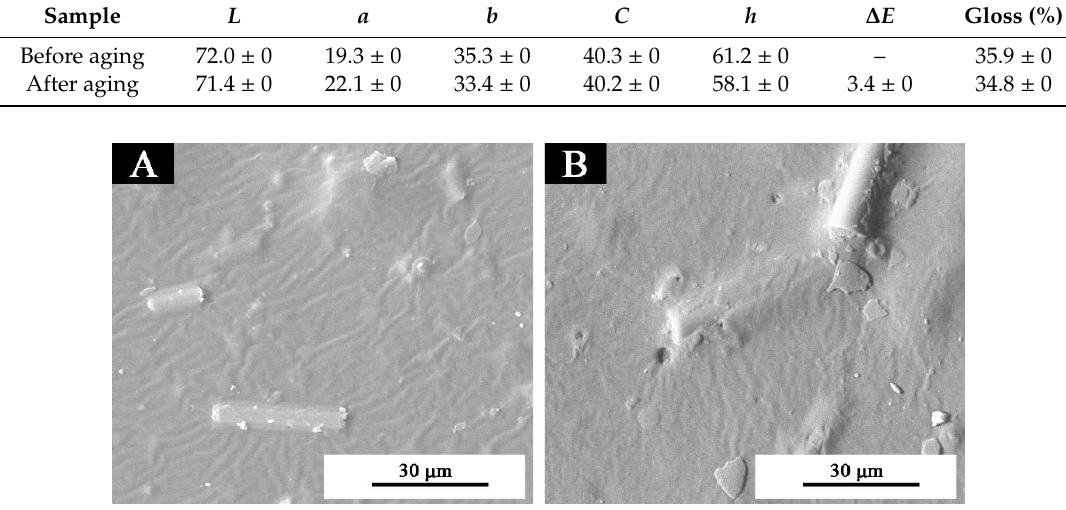
Figure 7. SEM of waterborne wood coatings with 3.0% glass fiber powder: ( A ) before and ( B ) after aging.